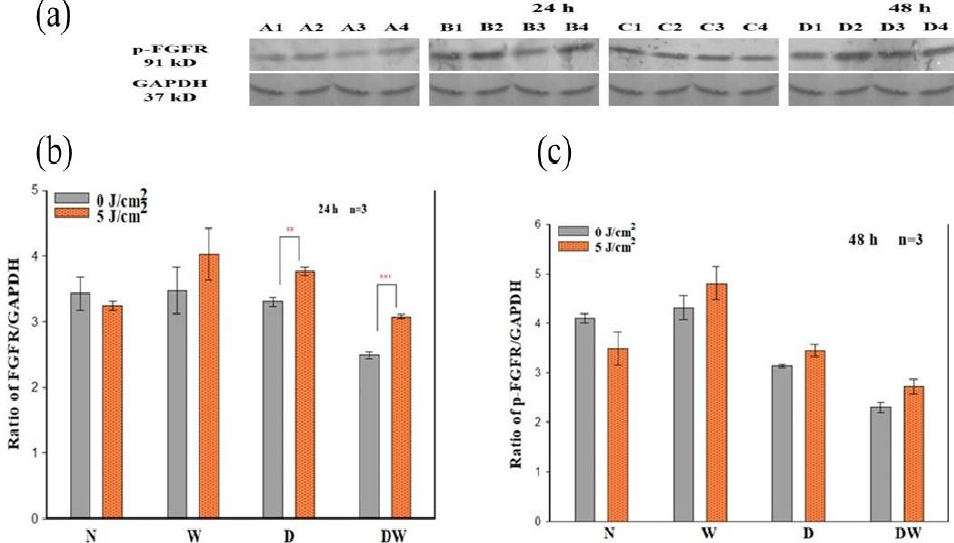
Figure 6. Effect of photobiomodulation on phosphorylated (p-) fibroblast growth factor receptor (FGFR) in normal (N), wounded (W), diabetic (D), and diabetic wounded (DW) cells irradiated at 660 nm with 5 J/cm 2 . GAPDH was used as a loading control. ( a ) Representative blots, A1: normal (0 J/cm 2 , 24 h); A2: wounded (0 J/cm 2 , 24 h); A3: diabetic (0 J/cm 2 , 24 h); A4: diabetic wounded (0 J/cm 2 , 24 h); B1: normal (5 J/cm 2 , 24 h); B2: wounded (5 J/cm 2 , 24 h); B3: diabetic (5 J/cm 2 , 24 h); B4: diabetic wounded (5 J/cm 2 , 24 h); C1: normal (0 J/cm 2 , 48 h); C2: wounded (0 J/cm 2 , 48 h); C3: diabetic (0 J/cm 2 , 48 h); C4: diabetic wounded (0 J/cm 2 , 48 h); D1: normal (5 J/cm 2 , 48 h); D2: wounded (5 J/cm 2 , 48 h); D3: diabetic (5 J/cm 2 , 48 h); and D4: diabetic wounded (5 J/cm 2 , 48 h). Quantification of the ratio of the intensity of protein-FGFR divided by GAPDH 24 h ( b ) and 48 h ( c ) post-irradiation. Data are expressed as ±SEM (n = 3). Significant probabilities compared to the non-irradiated controls are shown as ** p ≤ 0.01, and *** p ≤ 0.001 .